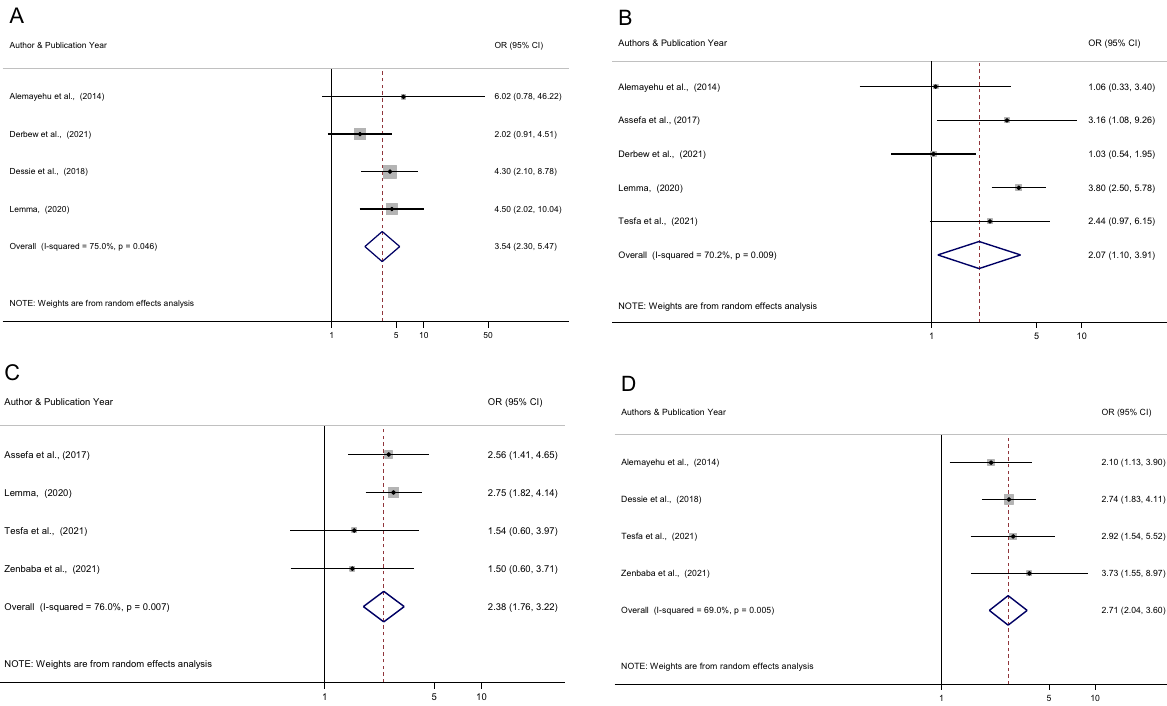
Fig. 5 Forest plot depicting pooled odds ratio (log scale) of the associations between prevalence of computer vision syndrome and its predictors ( A Previous history of eye disease, B Using eyeglass/spectacles, C Inappropriate sitting position, D Frequent use of the computer) in Ethiopia,